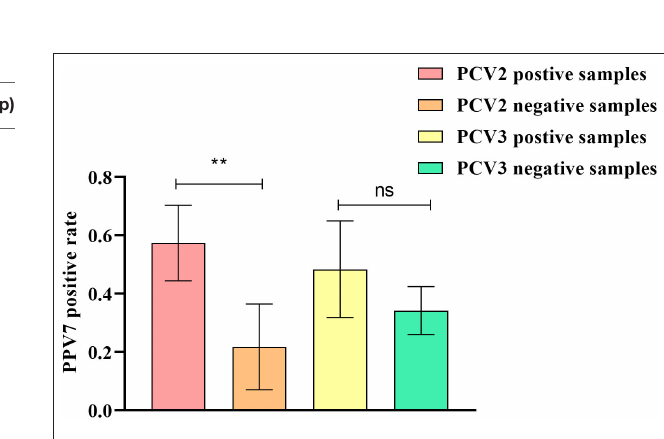
FIGURE 2 | Co-infection of PPV7 with PCV2 and PCV3. The PPV7 infection rates in PCV2 positive samples were significantly higher than that in PCV2 negative samples. However, there is no significant difference between the PPV7 infection rates in PCV3 positive samples and PCV3 negative samples. ** P < 0.01, ns P >